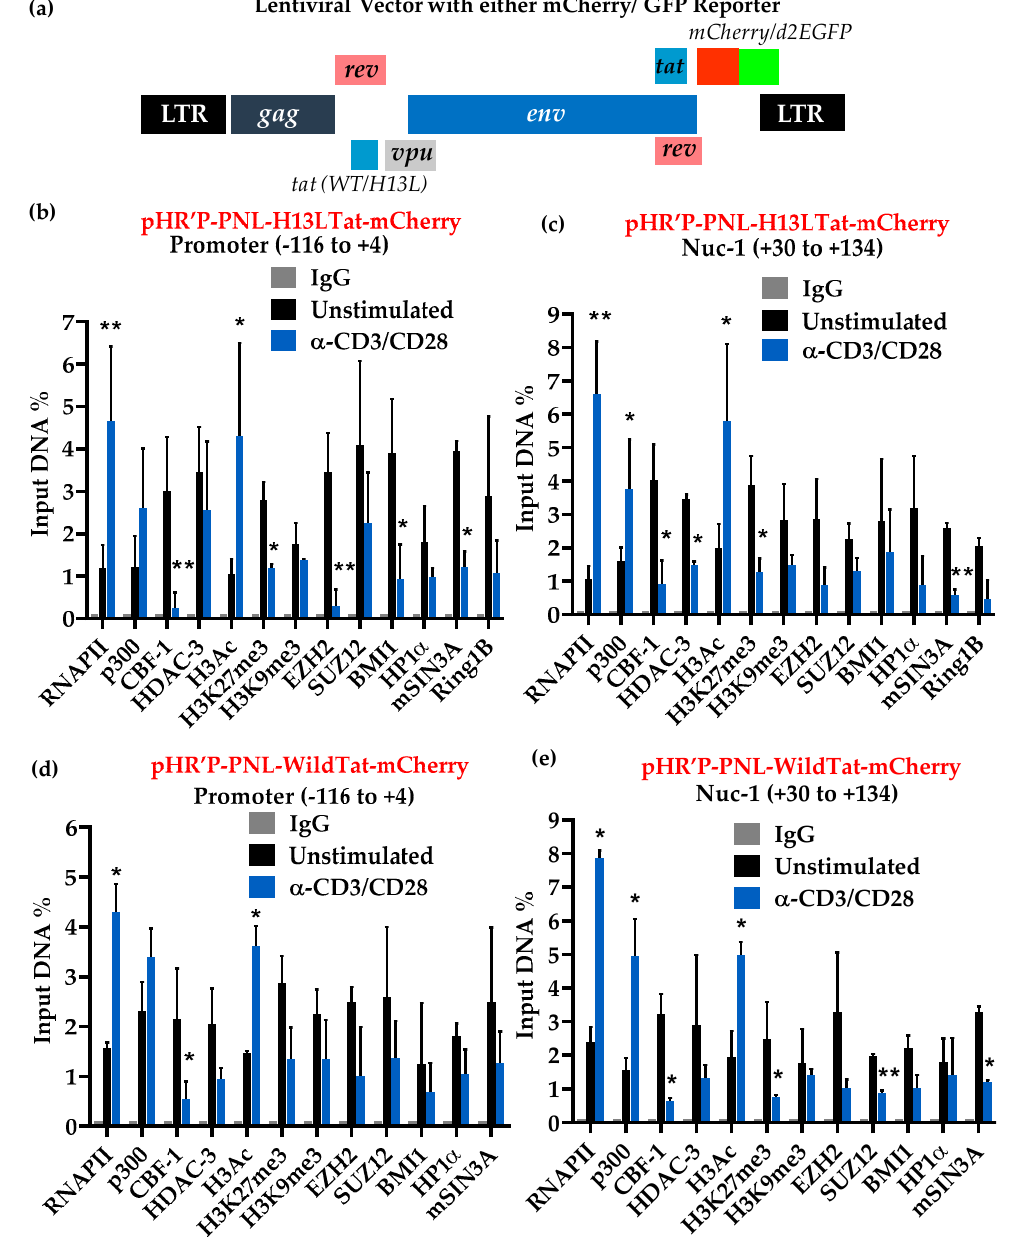
Figure 5. Cell activation leads to fluctuation in the levels of different chromatin-associated factors that belong to PRC1 and PRC2. ChIP analyses were performed before and after activation of latently infected primary CD4 + T cells with α -CD3 / -CD28 antibodies, in the presence of IL-2 for 30 min. ( a ) Structure of lentiviral vectors. mCherry was used as reporter depicted in this diagram. ChIP results in latency systems harboring proviruses with the vector pHR’-PNL-H13LTat-mCherry ( b , c ), and pHR’-PNL-wild-typeTat-mCherry ( d , e ). Error bars represent the SEM of two independent experiments and three separate qPCR measurements from each analysis. Graphs represent the average and standard deviation from three independent and replicate samples. Statistical analysis was calculated with GraphPad Prism 5.0 (GraphPad Software, San Diego, CA, USA). The p value of statistical significance was set at either; p < 0.05 (*) or 0.01 (**).